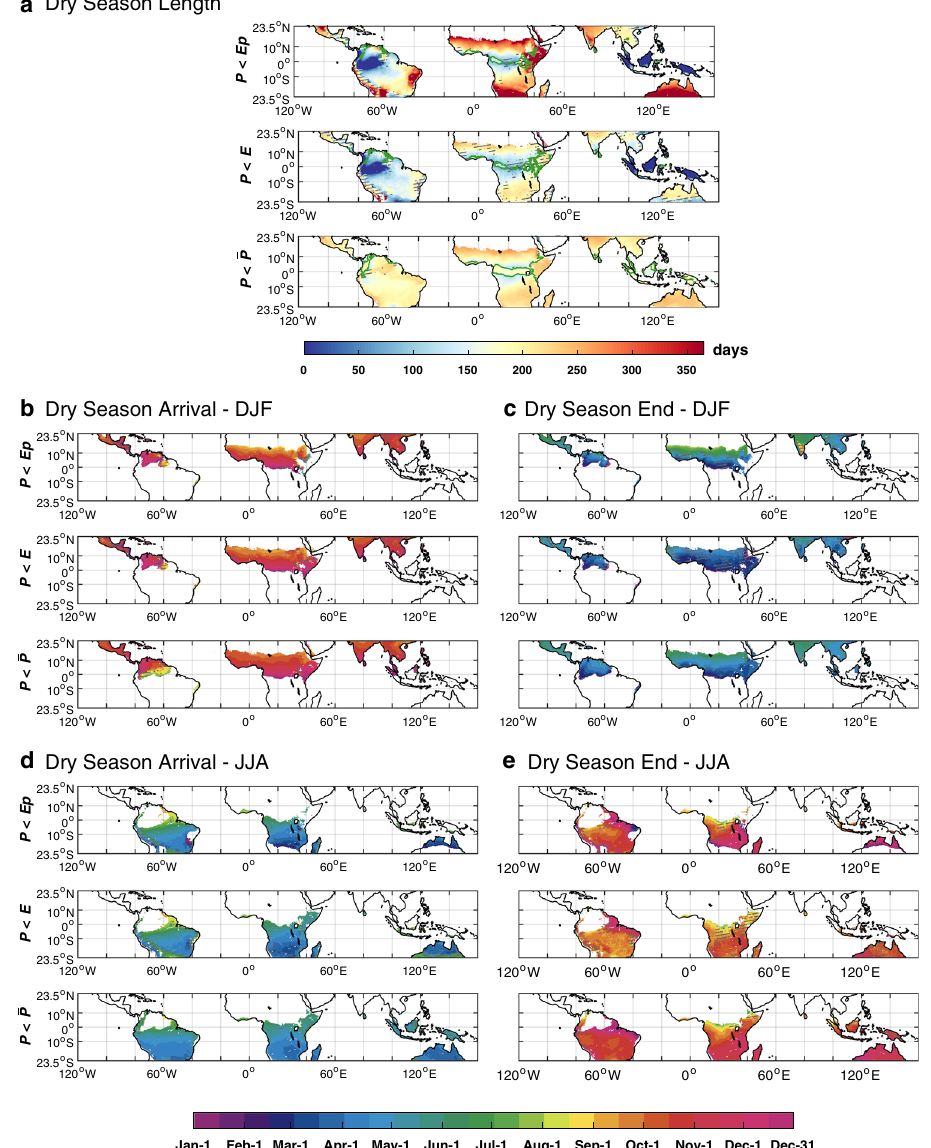
Fig. 2 Spatial patterns of tropical dry season length and timing under three de fi nitions. The dry season timing (arrival date and end date) is shown for northern tropics ( b , c ) and for southern tropics ( d , e ), respectively. In a green lines indicate the boundary of bimodal precipitation regimes inside which grid The hatched area in a – e indicates that the standard deviation of DSL is longer than 30 days (in a and b ) or the standard deviation of DSA or DSE is longer than 15 days (in d and e